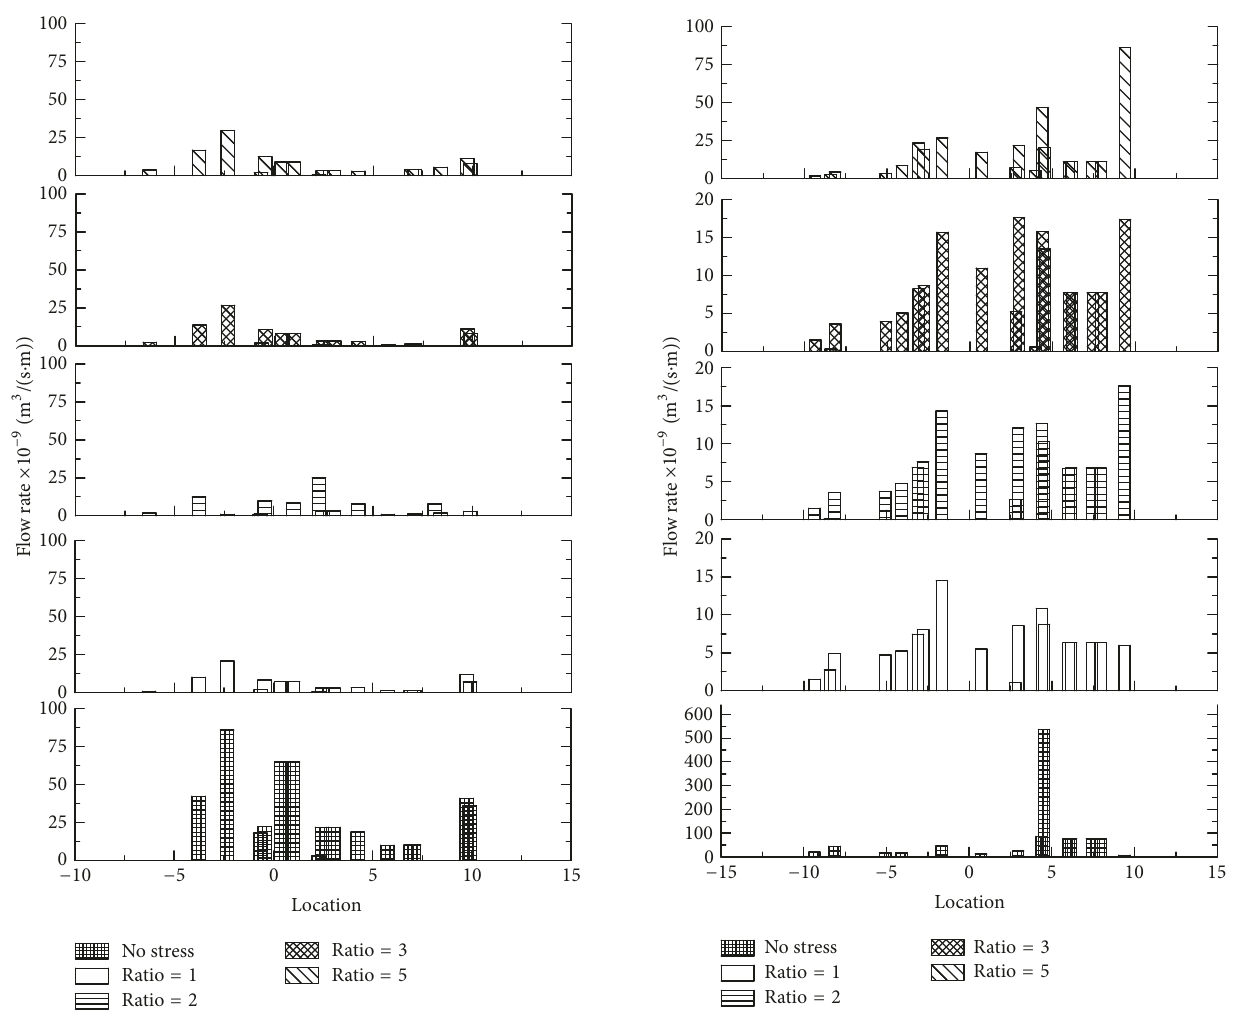
Figure 12: Flow rate distribution of fractures on the right outlet boundary.